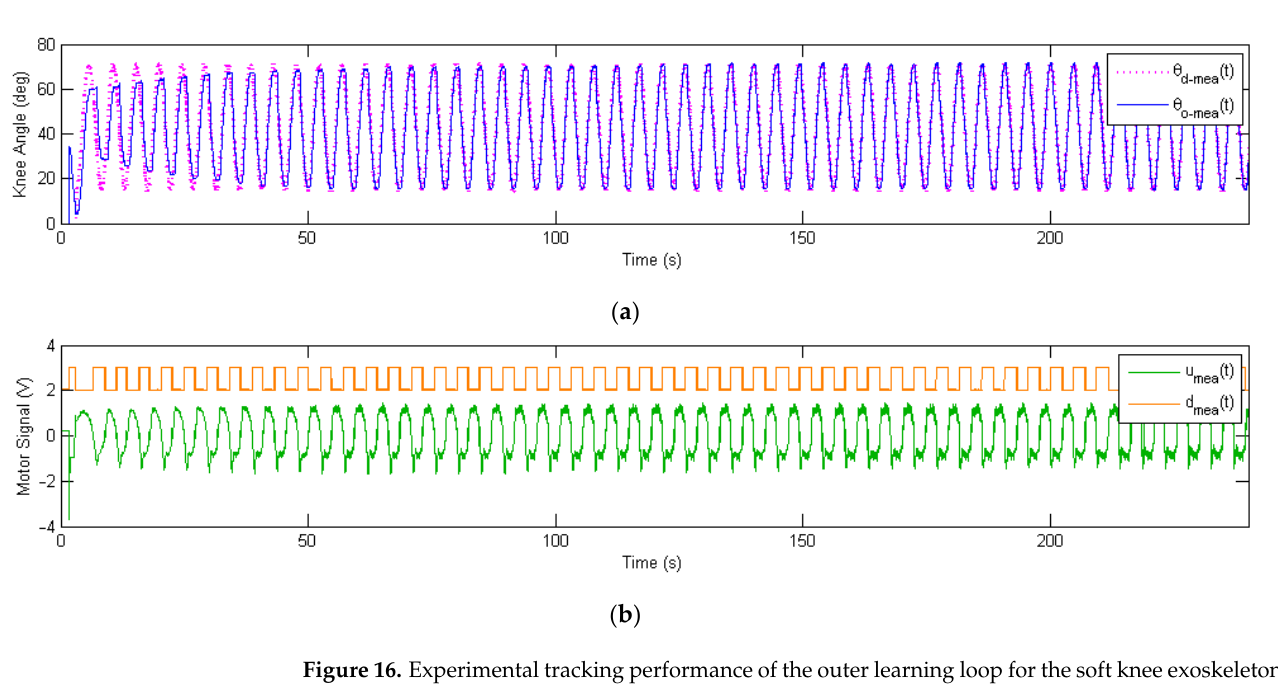
Figure 15. Measured tracking performance of the inner-loop digital servo control of the soft knee exoskeleton. ( a ) Experimental data of the sinusoidal response of the soft knee exoskeleton, with the motor control signal shown. ( b ) Experimental data of the reference input knee angle θ L − mea ( t ) v.s. the output knee angle θ O − mea ( t ) .